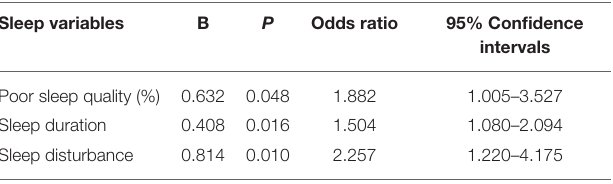
TABLE 4 | Results of the binary logistic regression analysis between sleep quality and enlarged perivascular spaces in white matter (WM-EPVS). Sleep variables